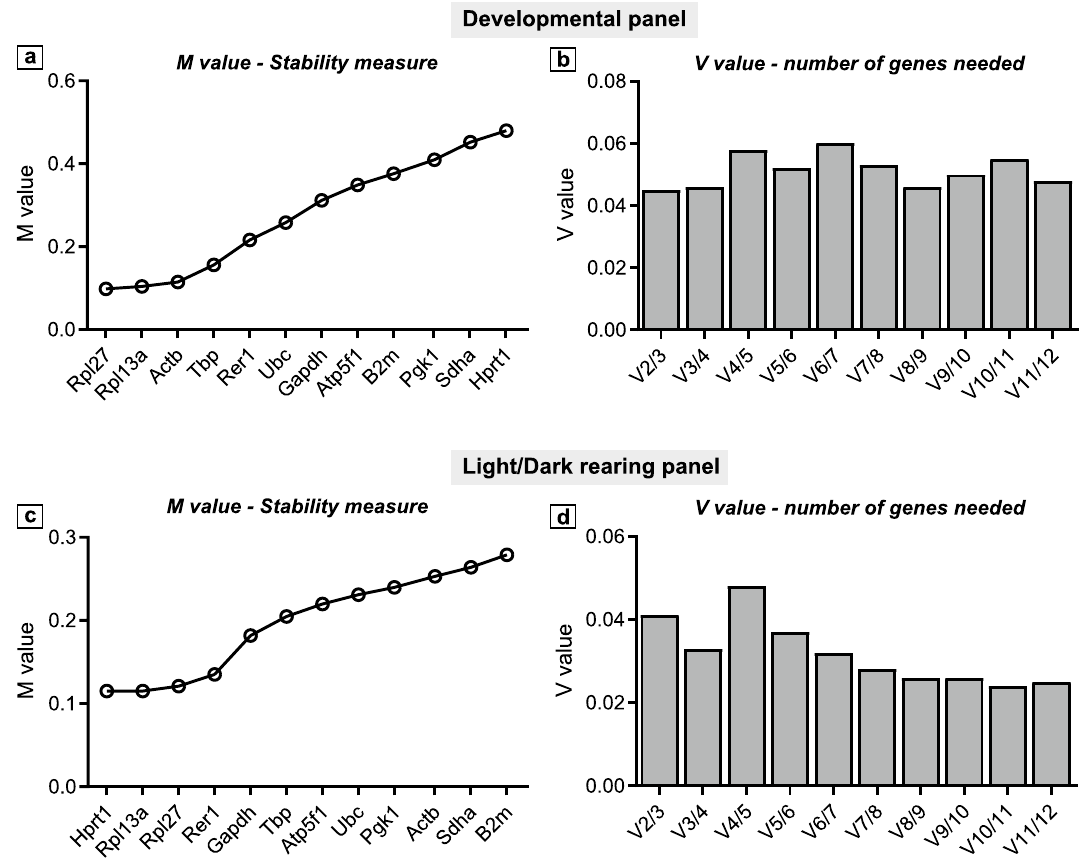
Figure 2. geNorm stability analysis. M value represents the gene expression stability in the Developmental ( a ) and in the Light/Dark rearing ( c ) panels. V value suggests the optimal number of reference genes per qPCR experiment in the Developmental ( b ) and in the Light/Dark rearing ( d )